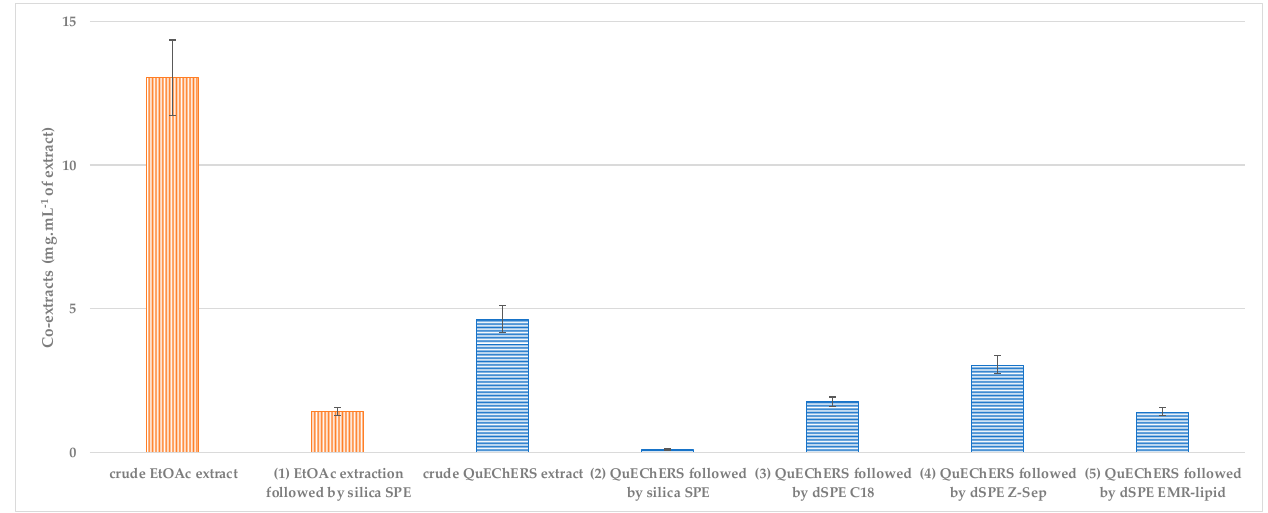
Figure 2. The amount of matrix co-extracts determined gravimetrically in smoked trout extracts before and after purification employing various sorbents for SPE and dSPE. Error bars display the repeatability of the procedure.